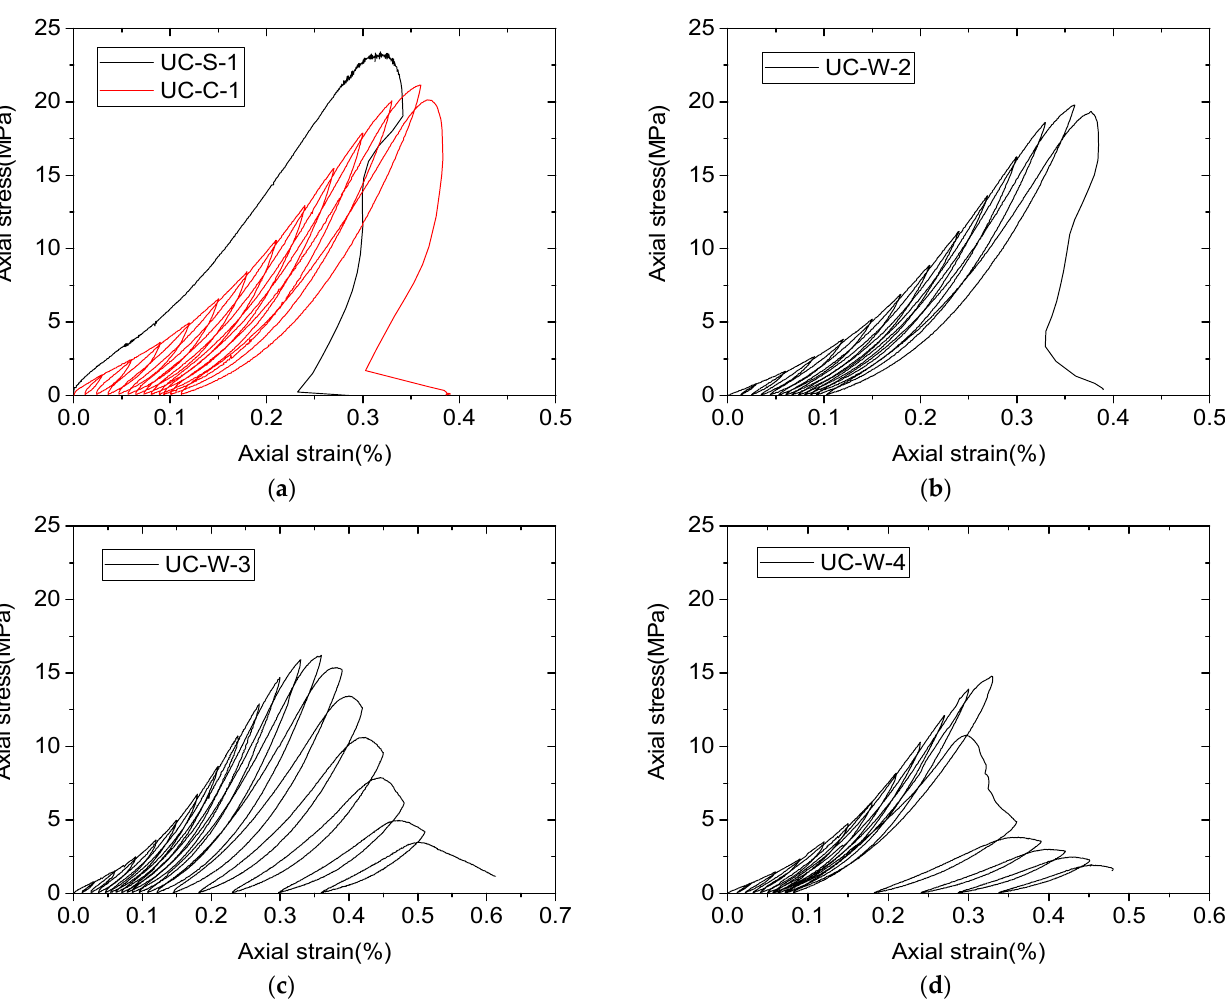
Figure 7. Stress-strain curves of the Beizao sandstone with different water content: ( a ) w = 0, ( b ) w = 2.992%, ( c ) w = 3.493%, and ( d ) w =